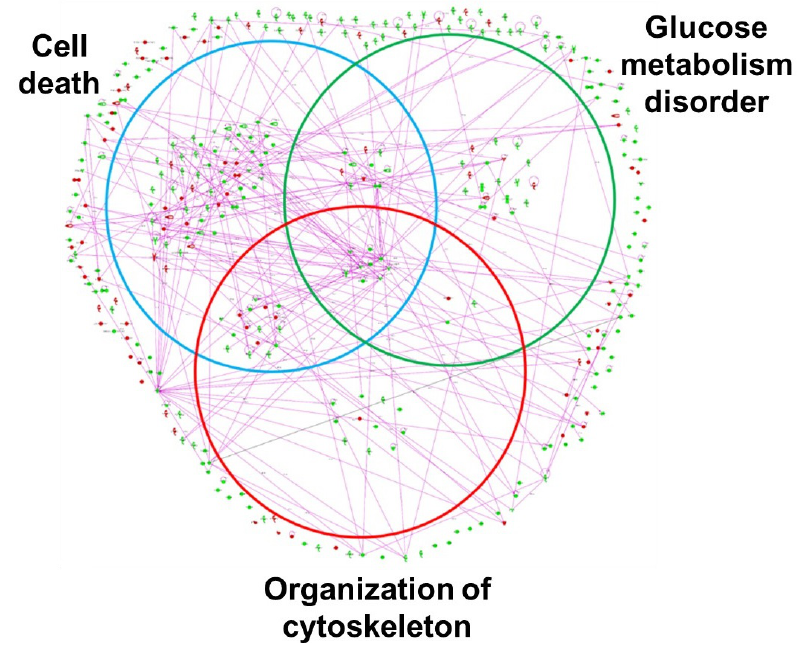
Figure 12. Network analysis of protein network in bladder ischemia by Ingenuity Pathways Analysis (IPA). Relevant networks were established from differentially expressed proteins (two-fold or greater) in ischemic group based on functional classification. Venn diagram networks were associated with subcategories related to cell death, glucose metabolism disorder, and cytoskeleton organization. Red dots indicate upregulated proteins and green indicate downregulated proteins. This figure is taken from our previous publication [48].